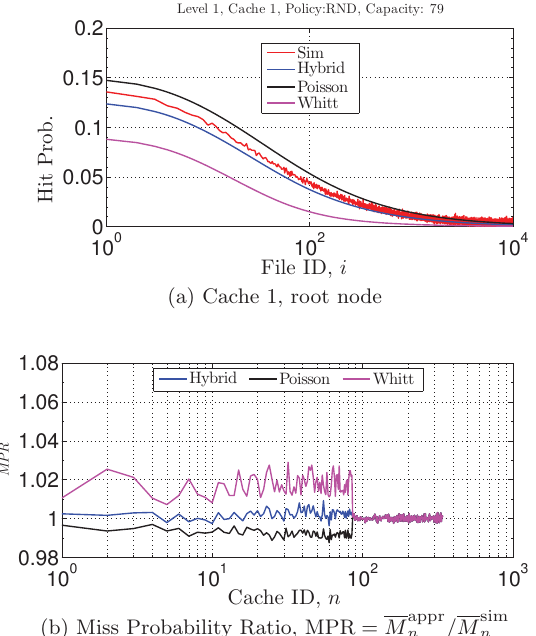
Figure 7: Simulations (Poisson arrivals on leaves, Zipf pop- ularity). Poisson, Whitt, and Hybrid approximations. Het- erogeneous ternary tree, depth 5, K = 10 4 ,C ∈ [50 , 150].